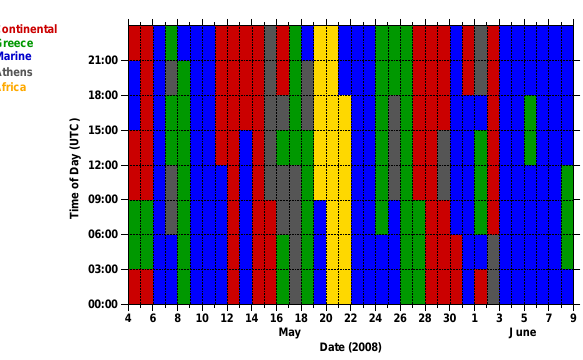
Fig. 3. Source region analysis based on FLEXPART footprint plots. Air masses were categorized based on their source region using PES of their footprint residence time plots (Stohl et al., 2005). A trajec- tory was attributed to a category if the source region had a PES value above 0.9nskg − 1 in the corresponding footprint plot. Time of day corresponds to